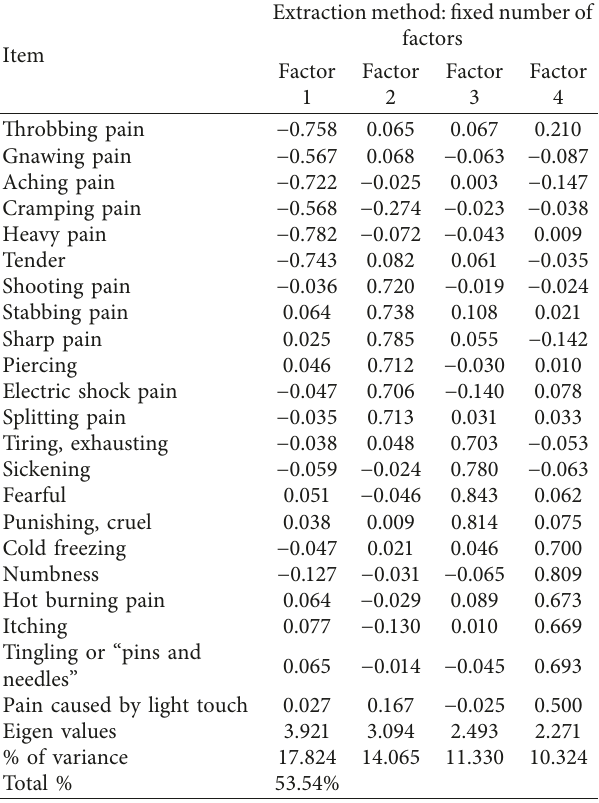
Table 2: Factor structures and loadings of 22 items in SF MPQ-2. Table 3: Internal consistencies for each subscale in the current study, original study, and other